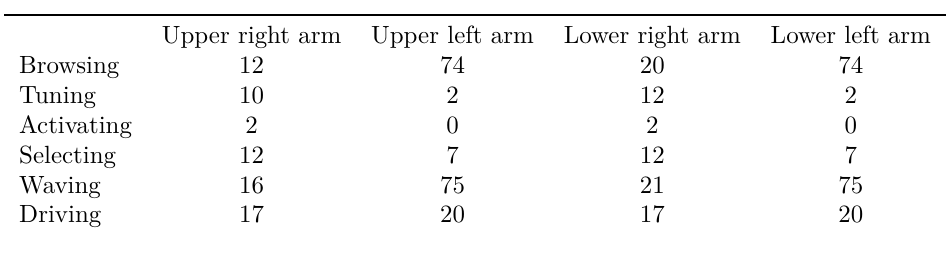
Table 6. Kinect rate of frames without detected limb relative to all frames in the dataset.